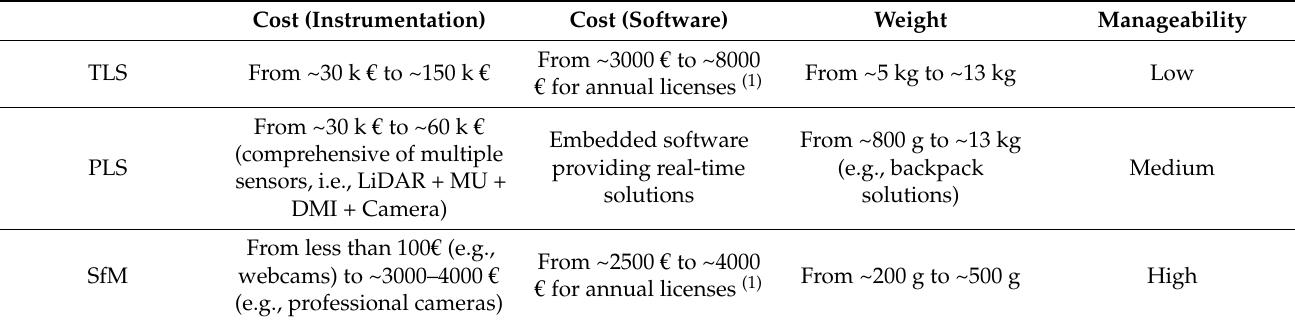
Table 8. Characteristics of the analyzed instrumentations and peculiarities of the employed